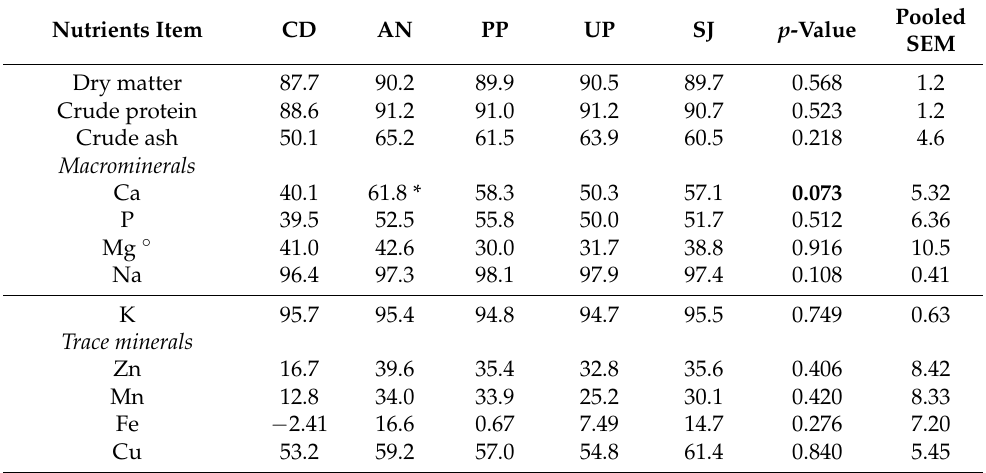
Table 5. Apparent total tract digestibility coefficients in dogs fed with a control diet supplemented or not with different intact